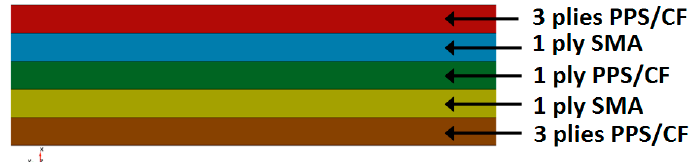
Figure 9. Layup configuration of the simplified model.